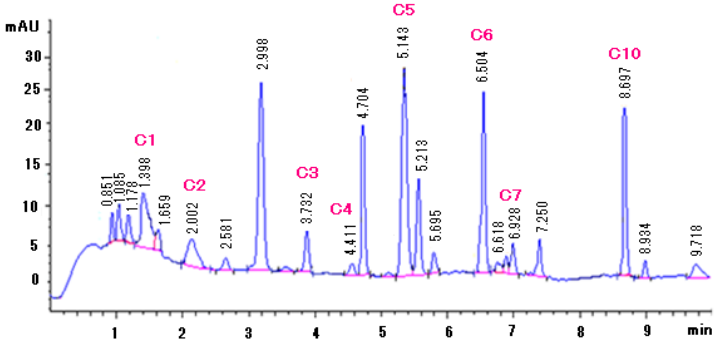
Figure 4. Chromatogram representing the separation of leaves L 4 sample using the developed and validated method.